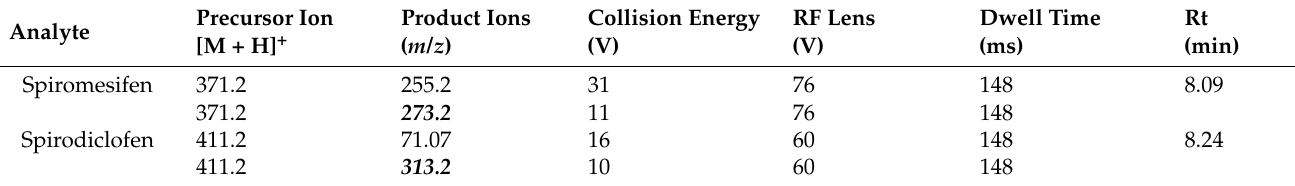
Table 1. MS/MS parameters for determination of spiromesifen and spirodiclofen.